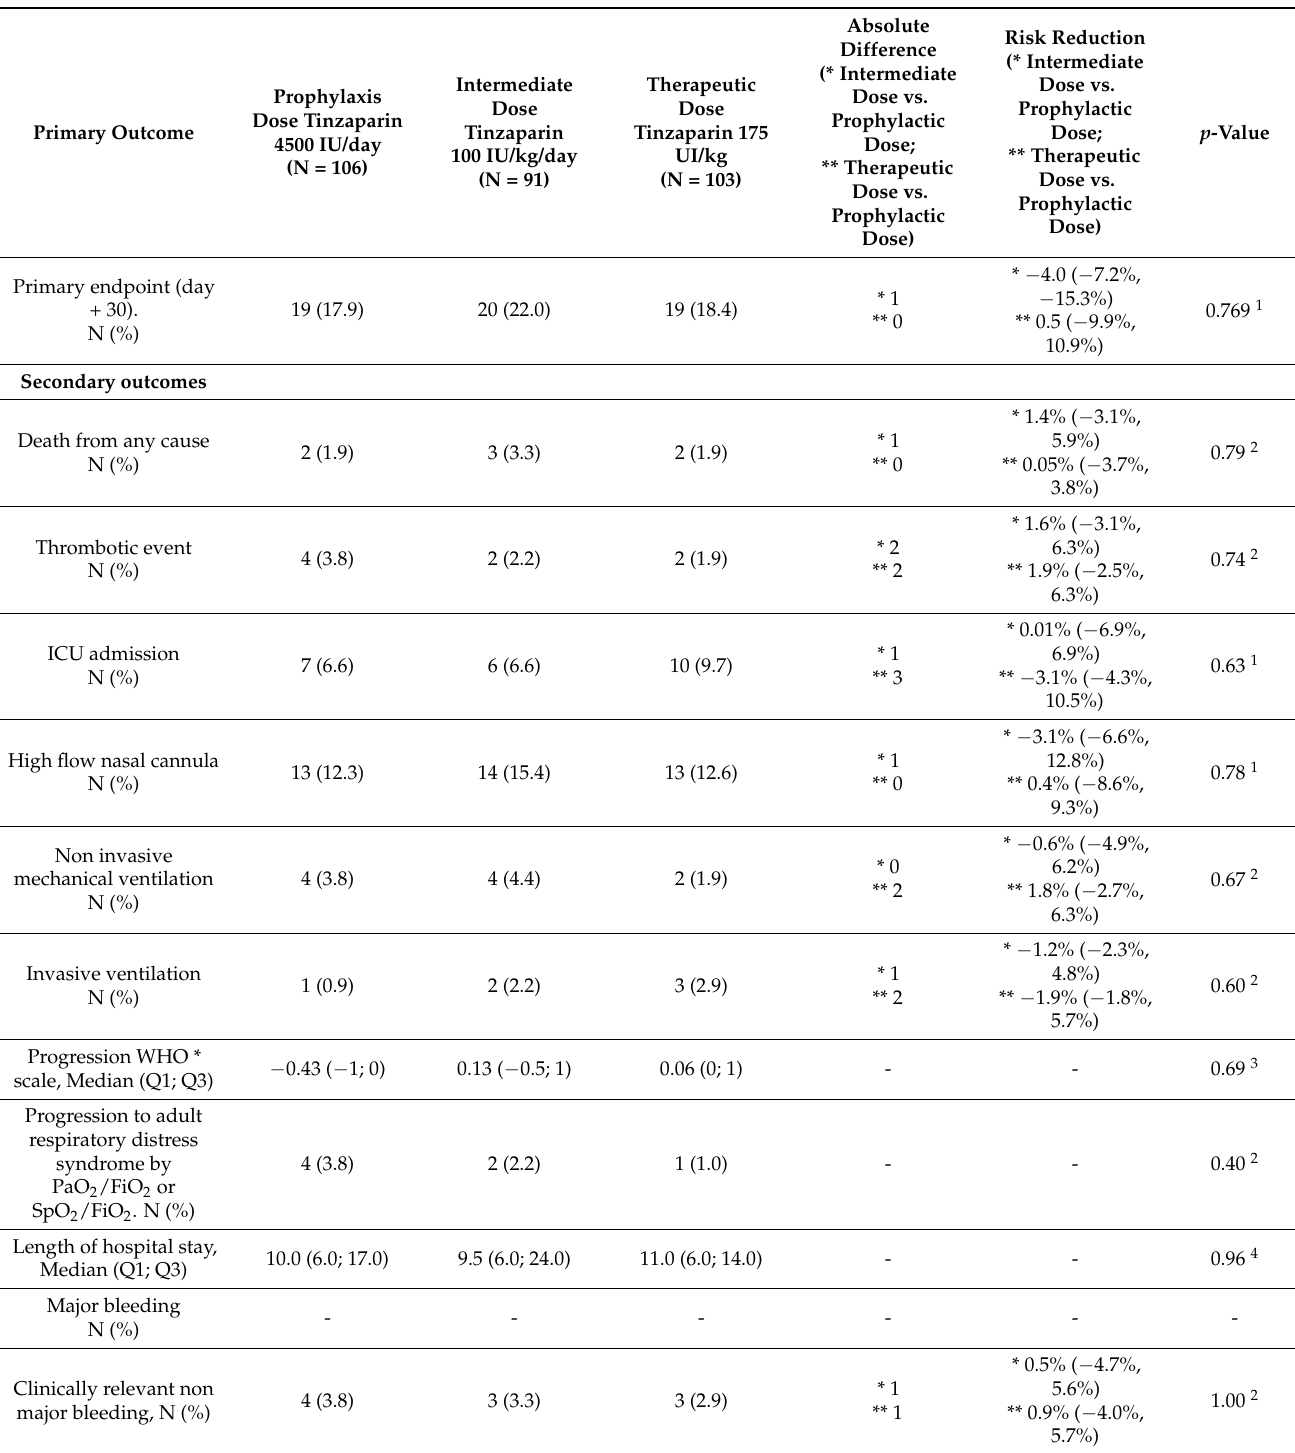
Table 2. The primary endpoint was the composite outcome of death, need for mechanical ventilation (invasive or noninvasive or high-flow therapy via nasal cannula), and venous or arterial thrombosis within 30 days after